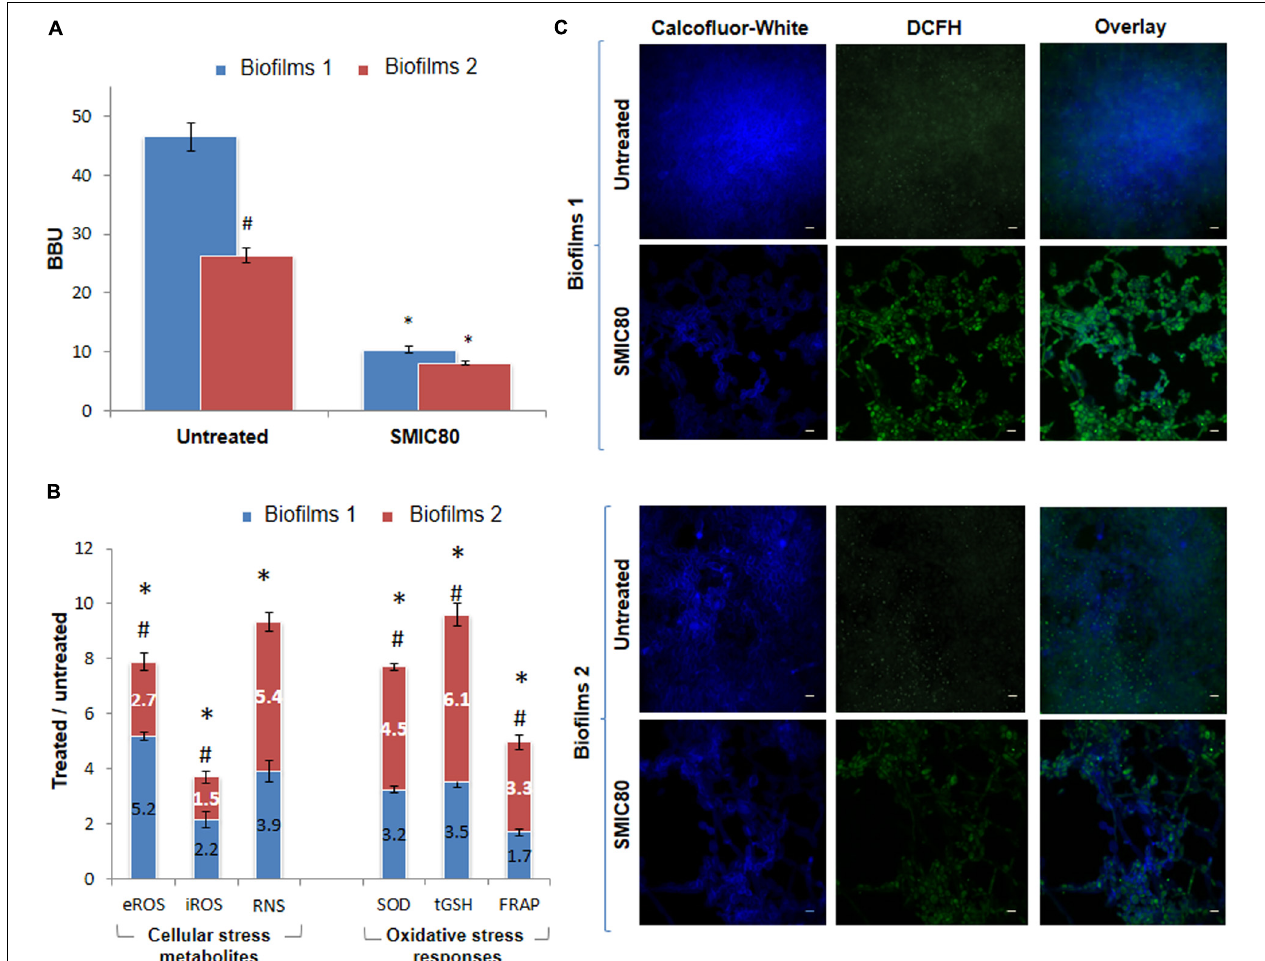
FIGURE 4 | Quantification of Candida tropicalis NCPF 3111 biofilms after treatment with sessile minimum inhibitory concentration 80 (SMIC80) of Amphotericin B (AmB). (A) Biofilm biomass units (BBU) of biofilms 1 (B1) formed from planktonic culture cells and exposed to AmB (200 µ g mL − 1 ) and biofilms 2 (B2) formed from persister cells (PCs1) that survived the B1 treatment, and were exposed to a second AmB treatment (200 µ g mL − 1 ). (B) Cellular stress metabolites: extracellular and intracellular reactive oxygen species (eROS and iROS) and reactive nitrogen species (RNS) with respect to untreated biofilms. Oxidative stress responses (OSR): superoxide dismutase (SOD), total reduced glutathione (tGSH) and total antioxidant system determined by ferrous reduction antioxidant power (FRAP) assay with respect to untreated condition for B1 and B2 of C. tropicalis . (C) Confocal scanning laser microscopy (CLSM) images of untreated B1 and B2 and after treatment with AmB at SMIC80. Blue channel shows Calcofluor-White in sessile cell walls, and green channel shows the oxidation of the 2 (cid:48) ,7 (cid:48) dichlorodihydrofluorescein diacetate probe (DCFH-DA) as an indicator of ROS production inside the biofilms. iROS was quantified as the 2 (cid:48) ,7 (cid:48) dichlorofluorescein (DCF) fluorescence by using NIH-Image J. CLSM images showing two-color (blue and green) merge are shown, with a magnification of 600 × and scale bar of 5 µ m. All experiments were performed in triplicate, for three independent experiments, and the numerical data are presented as means ± standard deviation. *Denotes statistical significance at p < 0.01 for differences when compared with untreated biofilms. # p < 0.01 differences considered significant for comparisons between B1 and